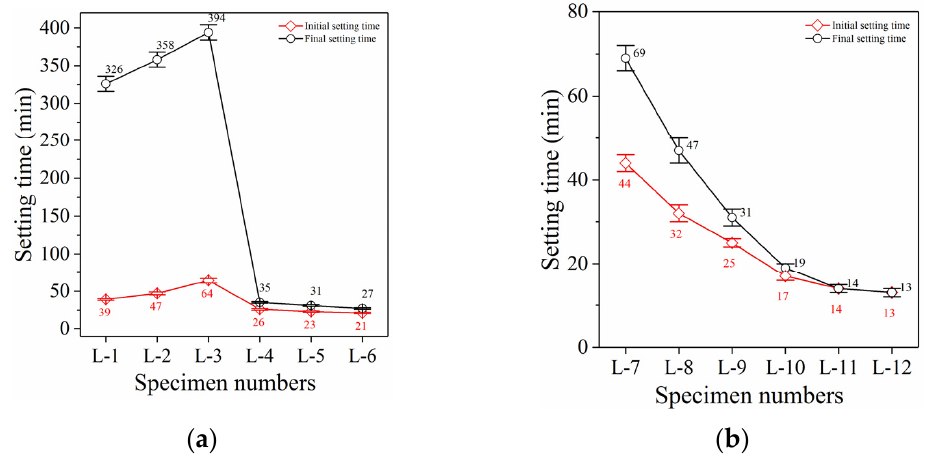
Figure 2. Analysis of condensation behavior. ( a ) Portland cement grouting specimens. ( b ) GBFS alkali-activated grouting specimens.